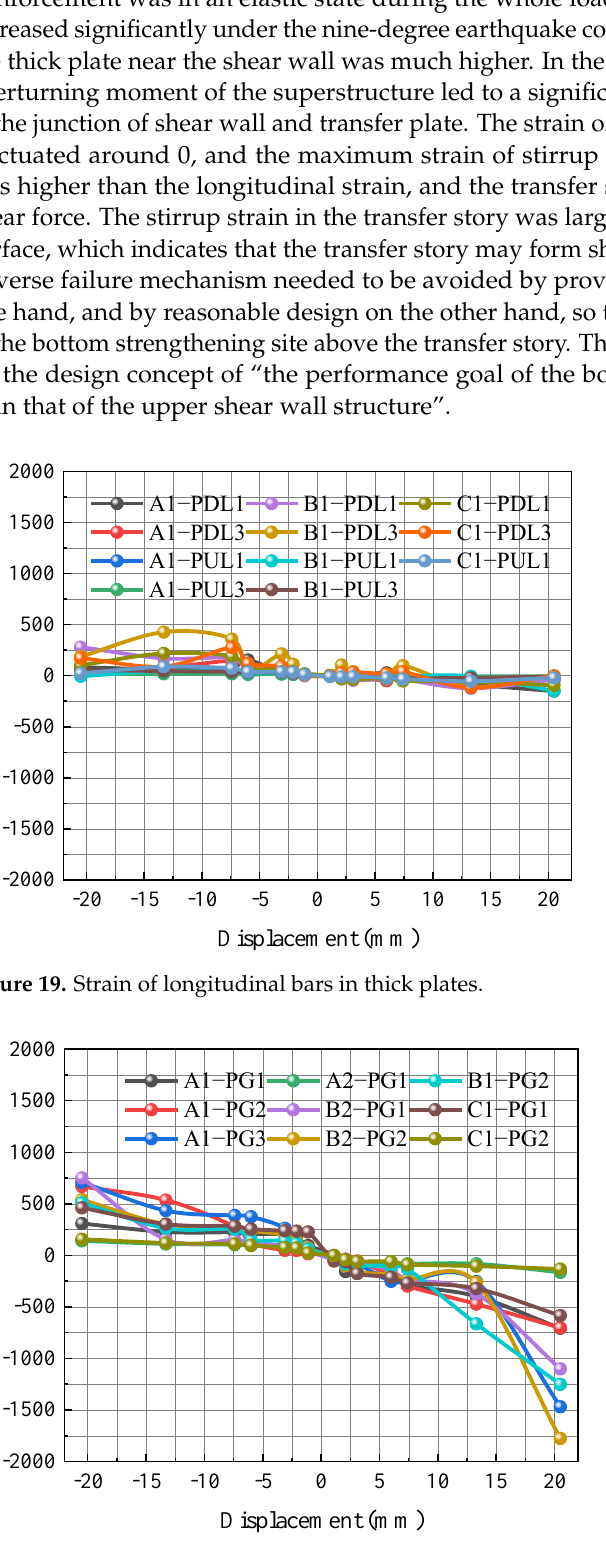
Figure 18. Longitudinal reinforcement strain of frame column.